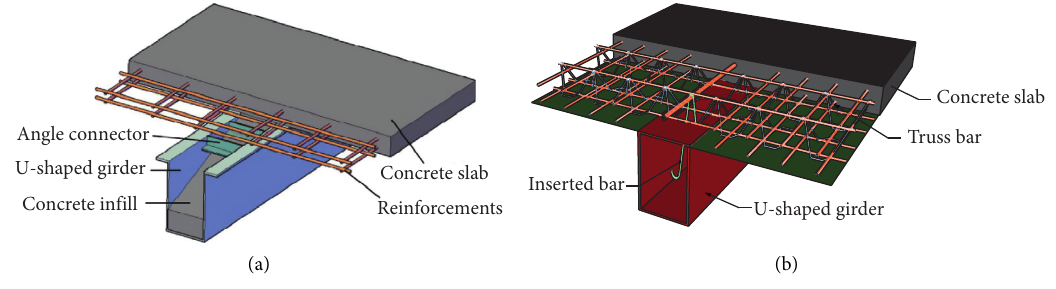
Figure 3: U-shaped steel-encased concrete composite